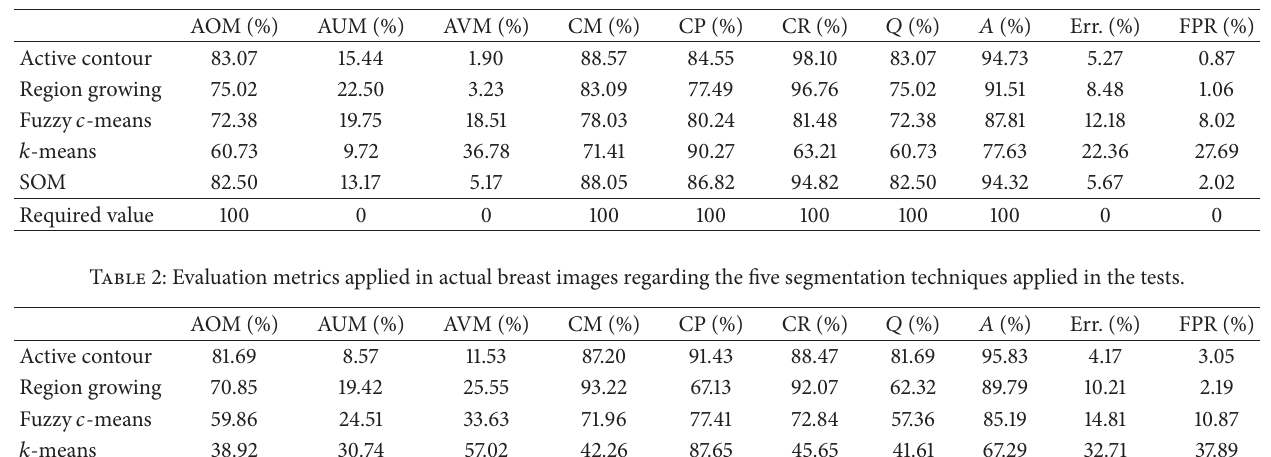
Table 1: Evaluation metrics applied to phantoms images regarding the five segmentation techniques applied in the tests.